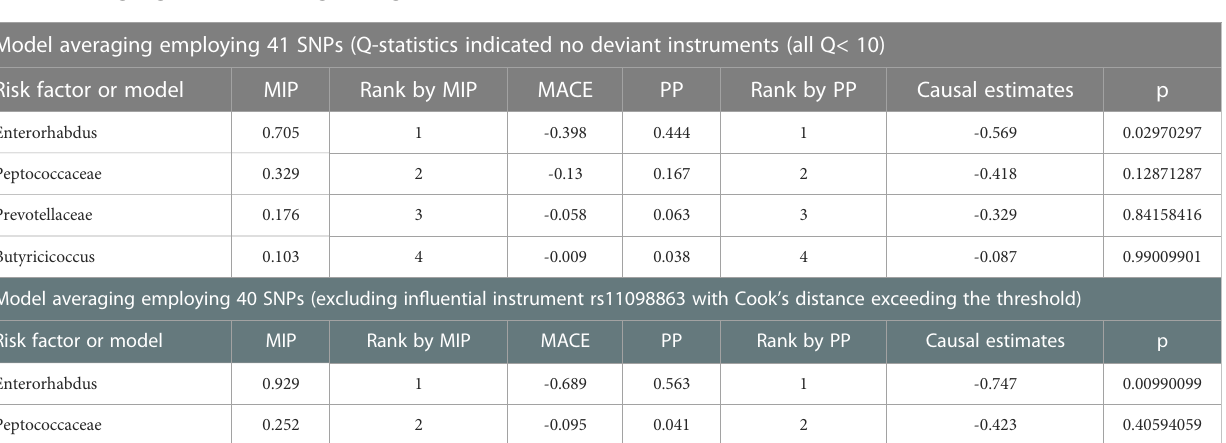
TABLE 2 Ranking of gut microbiota for IgAN using MR-BMA.